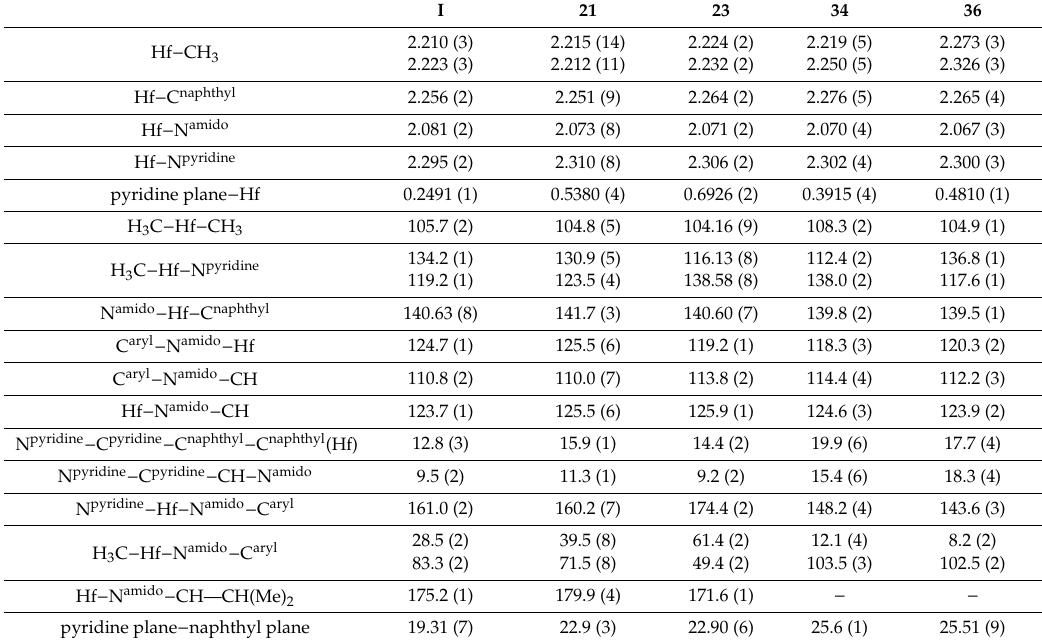
Table 1. Bond distances (Å) and angles ( ◦ ) determined by X-ray